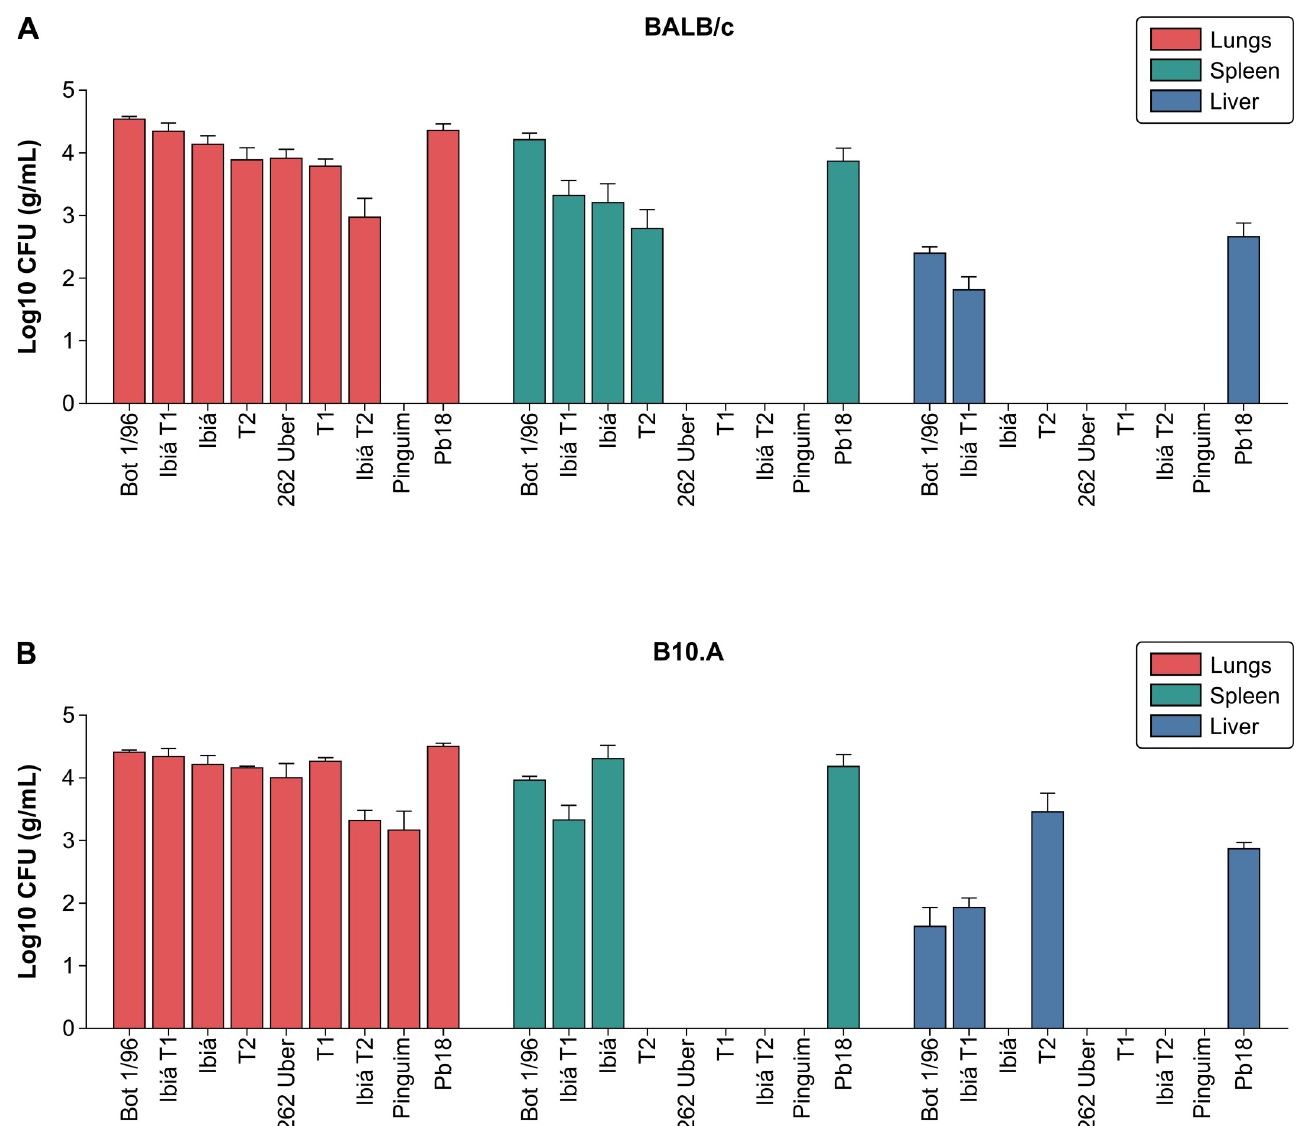
Fig 2. Fungal loads in different mouse tissues. Colony-forming units (CFUs) were obtained from samples of the spleen, liver, and lungs of BALB/c (A) and B10. A (B) mice infected intratracheally with 1 × 10 6 P . brasiliensis yeast cells. Mice were euthanized at 30 days after inoculation. Data are representative of two independent experiments and values are expressed in mean ± SD. Horizontal bars indicate statistical significance of differences between numbers of CFUs obtained from isolate samples and those of virulent control Pb18: � P < 0.05, Tukey’s test.